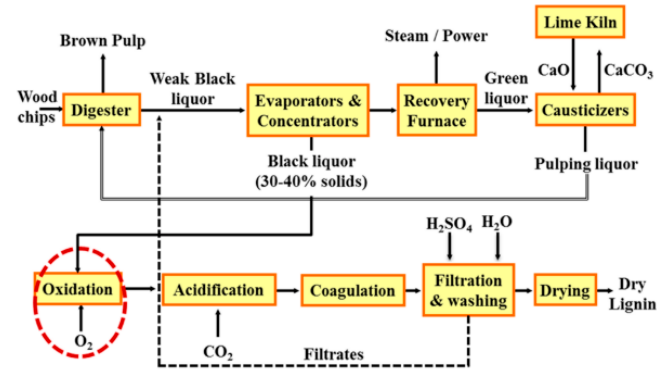
Figure 2. LignoForce System by FPInnovations and NORAM [18].